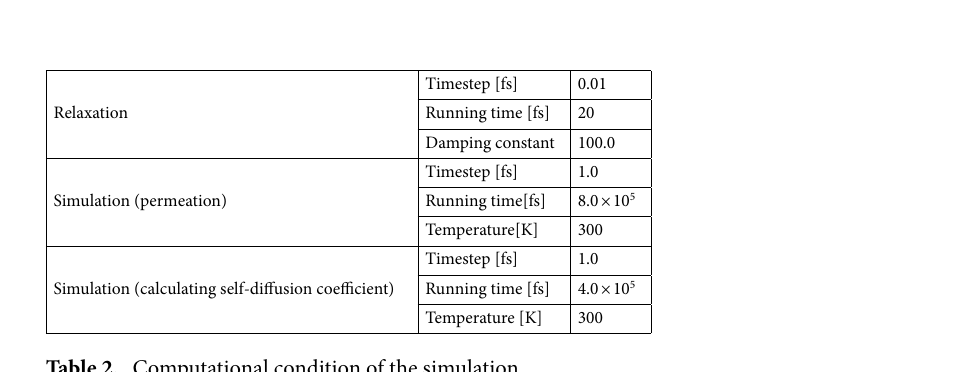
Table 2. Computational condition of the